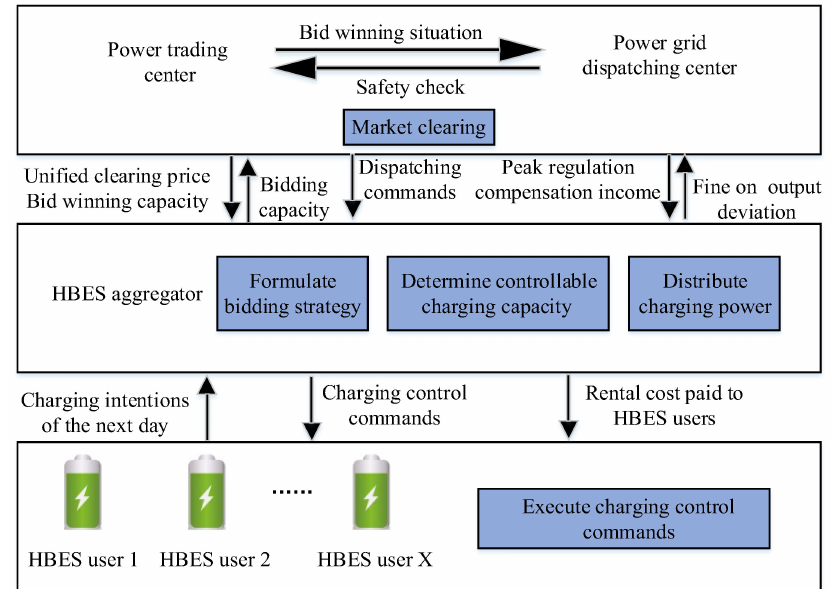
Figure 1. The framework of HBES participating in the